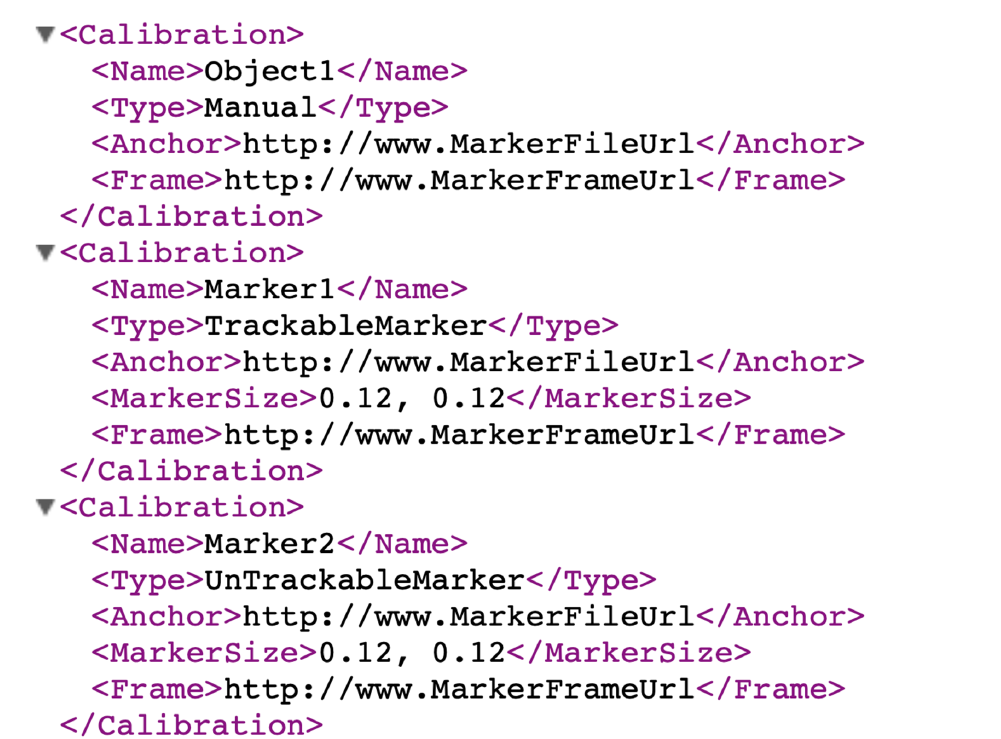
Figure 20. Example of Calibration element